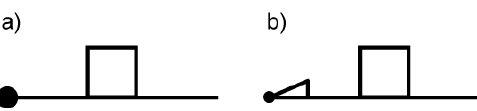
Figure 5. Attributes can be assigned to primal nodes and edges as well as to dual